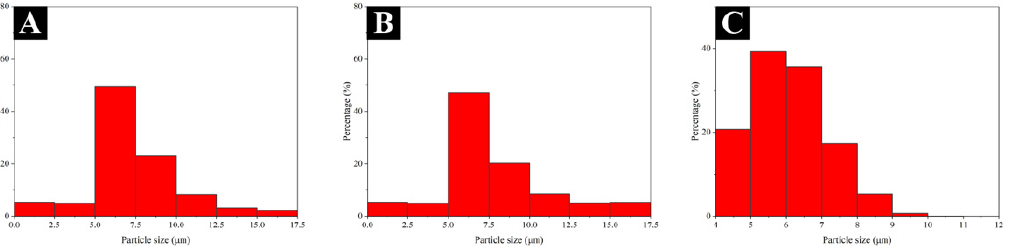
Figure 2. Particle size distribution of ( A ) transparent shellac microcapsules; ( B ) purple shellac microcapsules; ( C ) yellow shellac microcapsules.